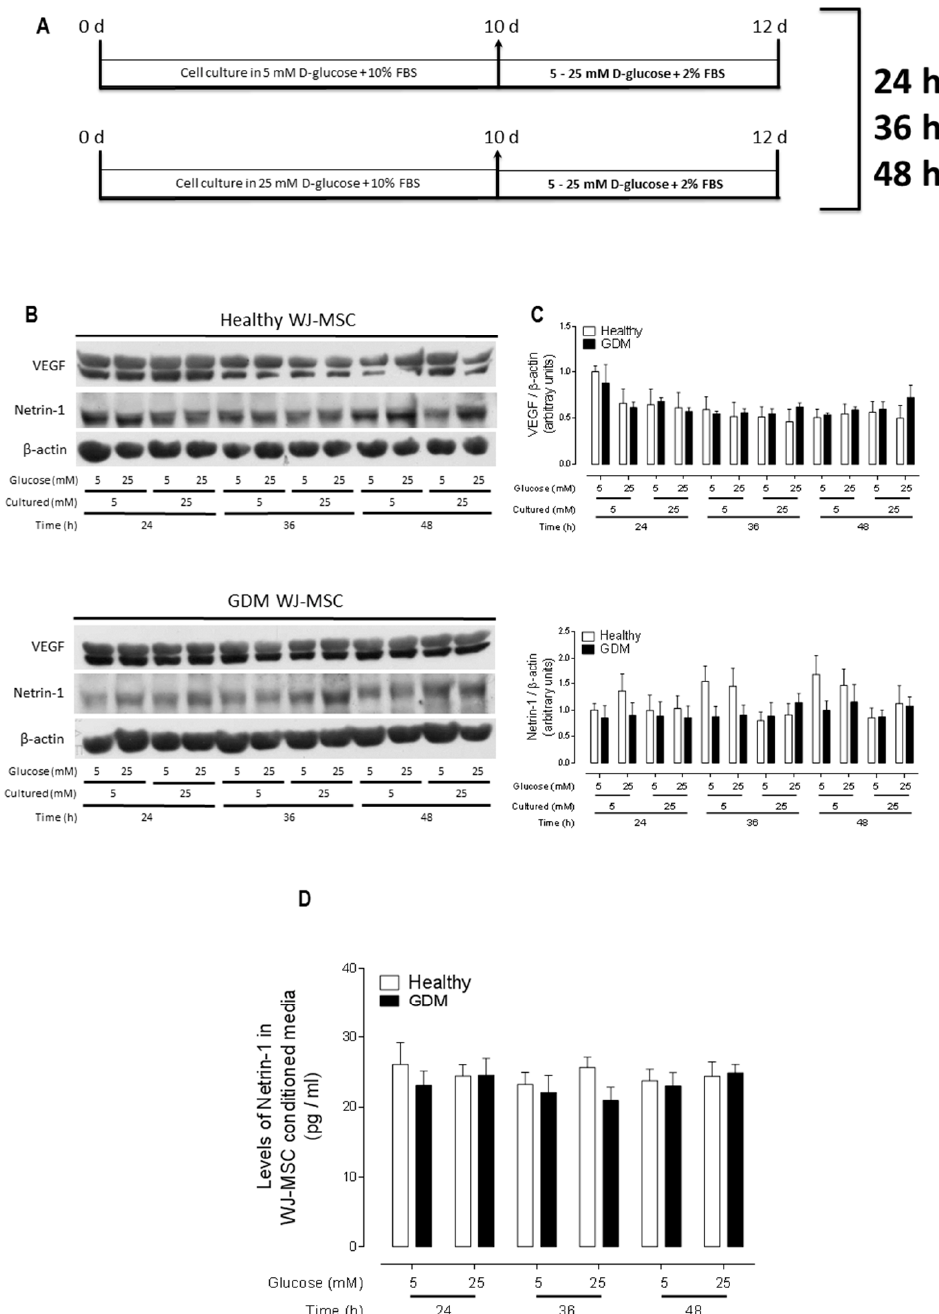
Figure 1. Netrin-1 expression and secretion do not change in healthy versus GDM WJ-MSC. ( A ) Scheme of the experimental procedures. WJ-MSC primary cultures were maintained for 10 days at the indicated glucose concentration in 10% FBS and then incubated for up to 2 more days in either 5 mM or 25 mM plus 2% FBS. Samples were collected at indicated times for analysis. The vertical arrow indicates initiation of differential D -glucose treatment. ( B ) Whole cell lysates were evaluated by Western blot for Netrin-1 expression in WJ-MSC from healthy and GDM cultures. VEGF was used as a positive control and β -actin was used as internal loading control. Exposure to different D -glucose concentration as indicated. ( C ) Data represent the mean of independent biological replicates ± SEM (healthy n = 12, GDM n = 6). ( D ) Quantitation of Netrin-1 by Elisa analysis. CM from healthy and GDM WJ-MSC was obtained to evaluate Netrin-1, CM was obtained with different D -glucose treatment at indicated time points ( n =